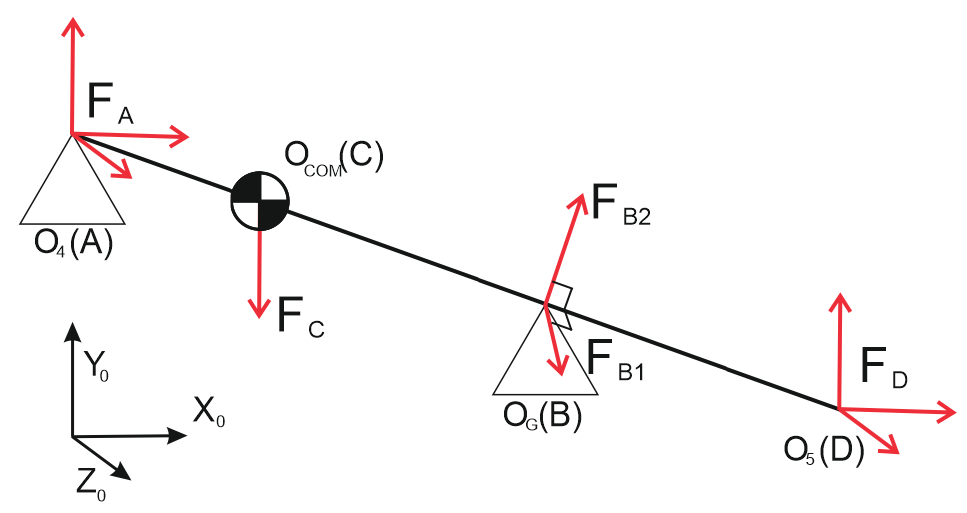
Figure 4. Forces at the manipulator.